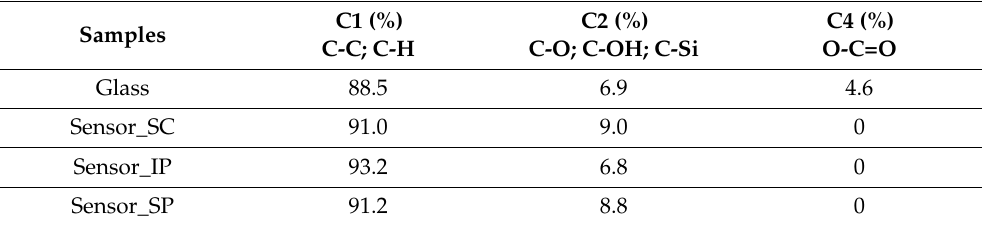
Table 4. Relative amounts of differently bound carbons obtained from the XPS survey spectra for the glass and optical sensor layers prepared with different techniques: spin coating (Sensor_SC), inkjet printing (Sensor_IP), and spray coating